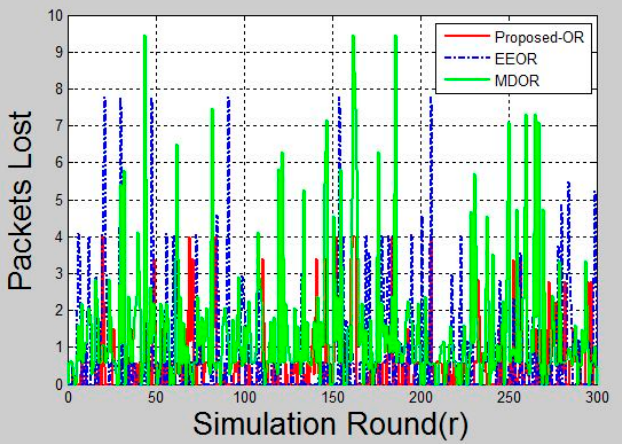
Figure 9. Packet loss during simulation.